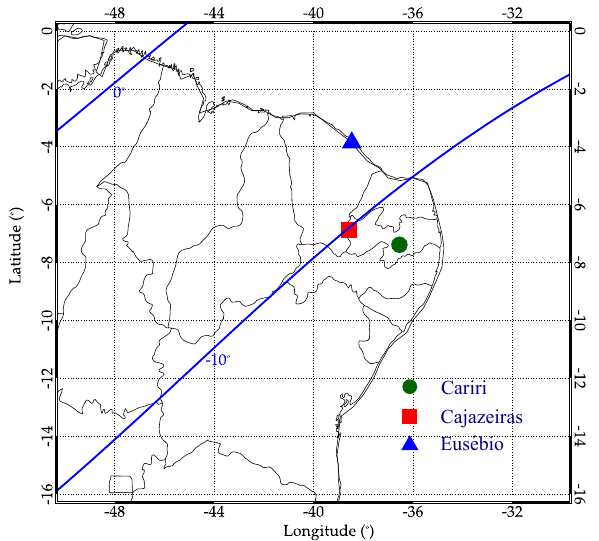
Figure 1. Map showing the geographic locations of the RENOIR instruments at São João do Cariri (green dot) and Cajazeiras (red box). The Digisonde is located at Eusébio (blue triangle). All in- struments are in the Brazilian northeast. The blue solid lines denote the geomagnetic equator (0 ◦ ) and − 10 ◦ for